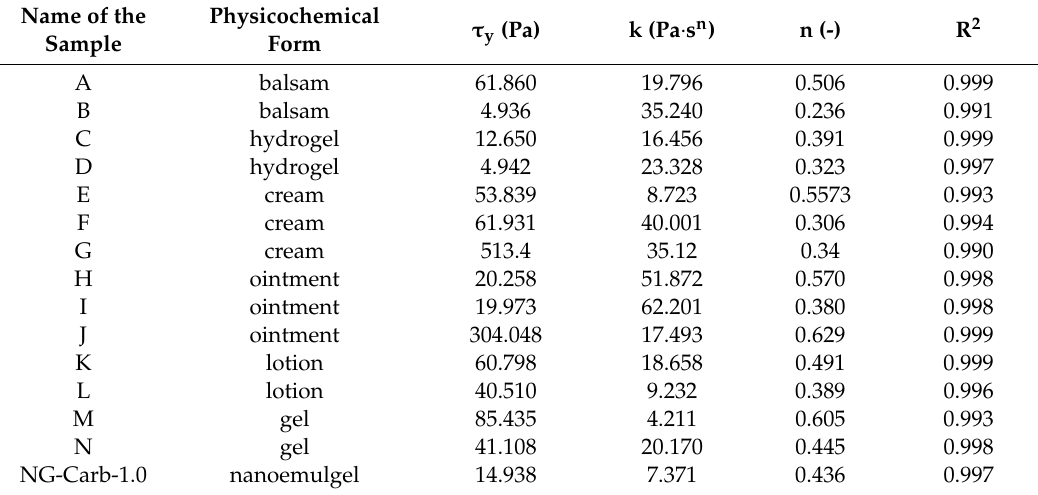
Table 6. Rheological parameters of a Herschel–Bulkley model for test